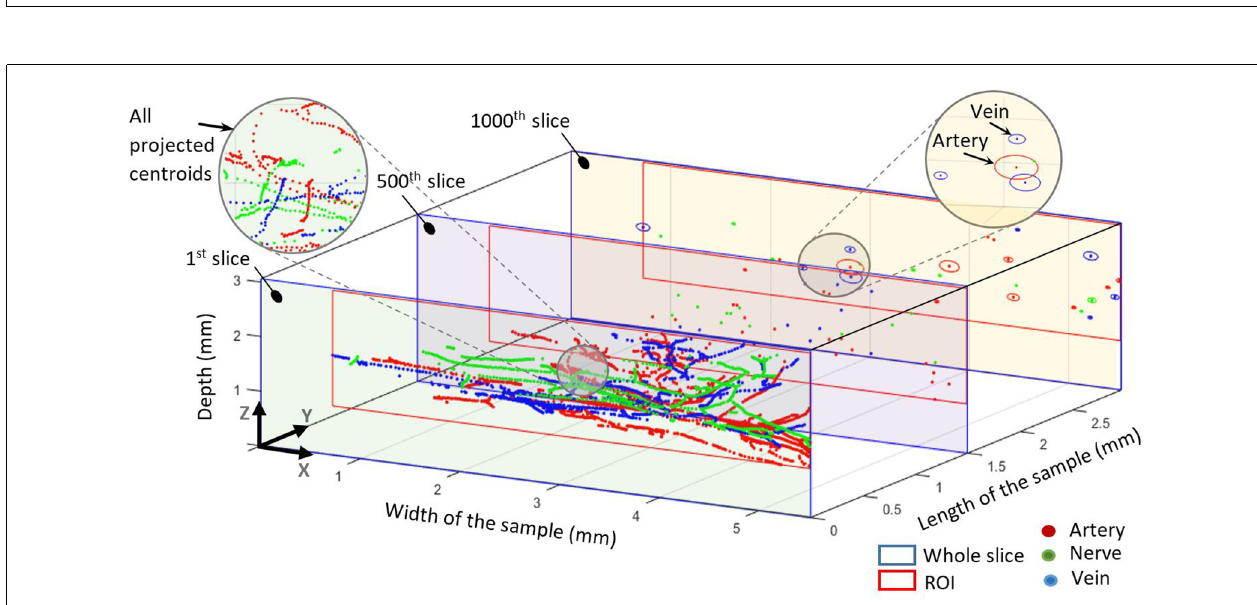
FIGURE 3 | Reconstructed nerves (green), arteries (red), veins (blue), epidermis (mustard), and cartilage (beige) from marked elements in HREM images.